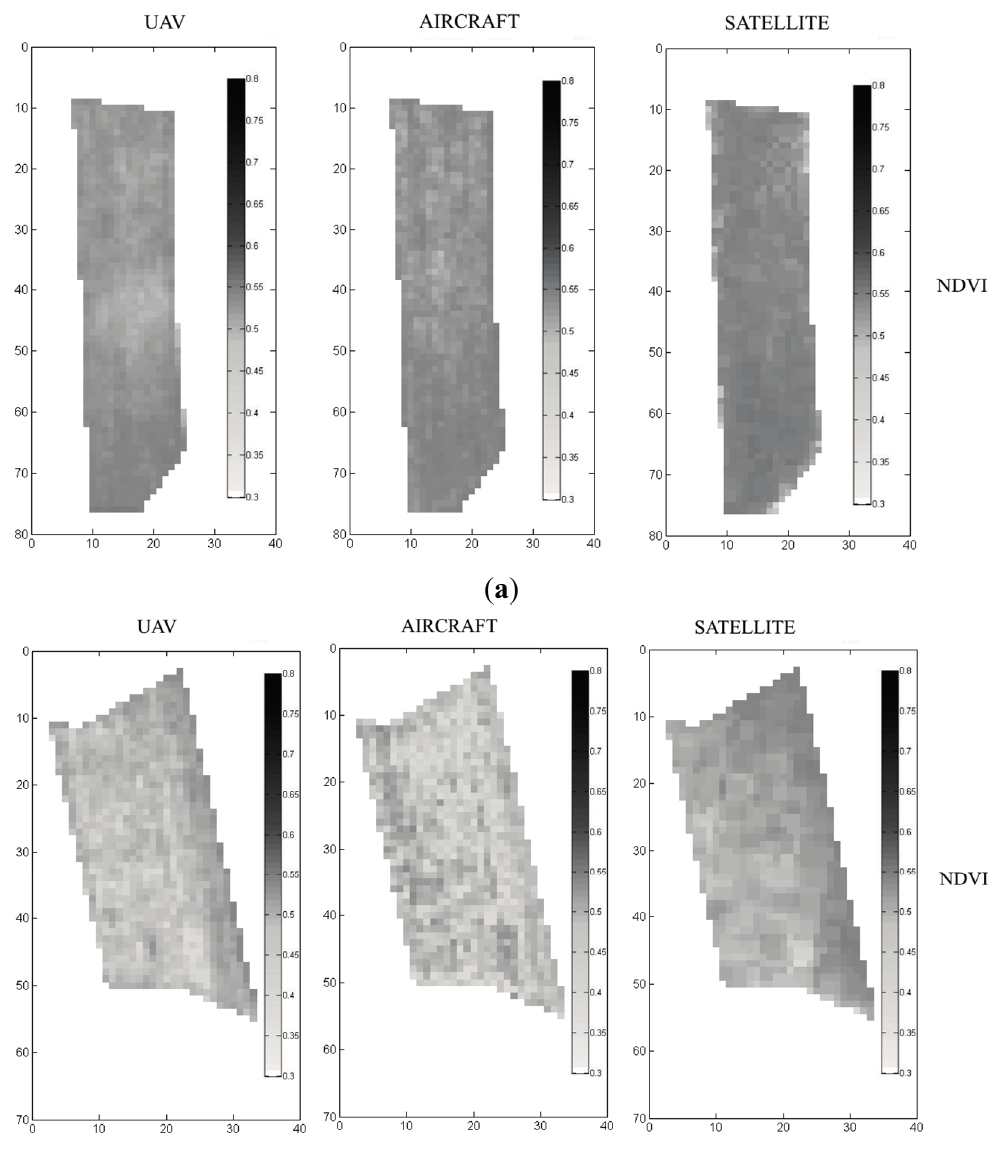
Figure 2. ( a ) V1 images rescaled at 5-m resolution for the three platforms; and ( b ) V2 images rescaled at 5-m resolution for the three